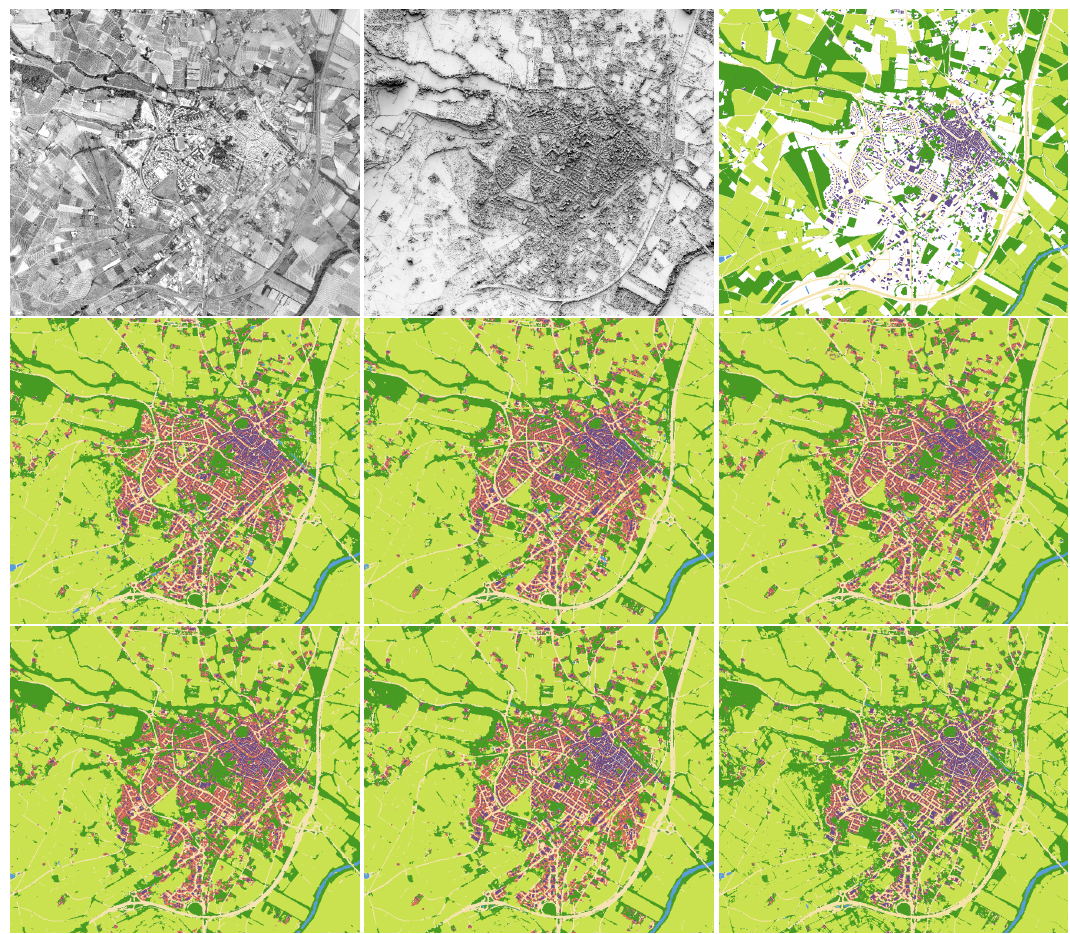
Figure 6. 2001: (from left to right) top row: ortho-image, shading map, cleaned ground truth; middle row: UNet:im, UNet:im+dsm, UNet:im+sh; bottom row: FuseNet:im+dsm, FuseNet:im+sh,